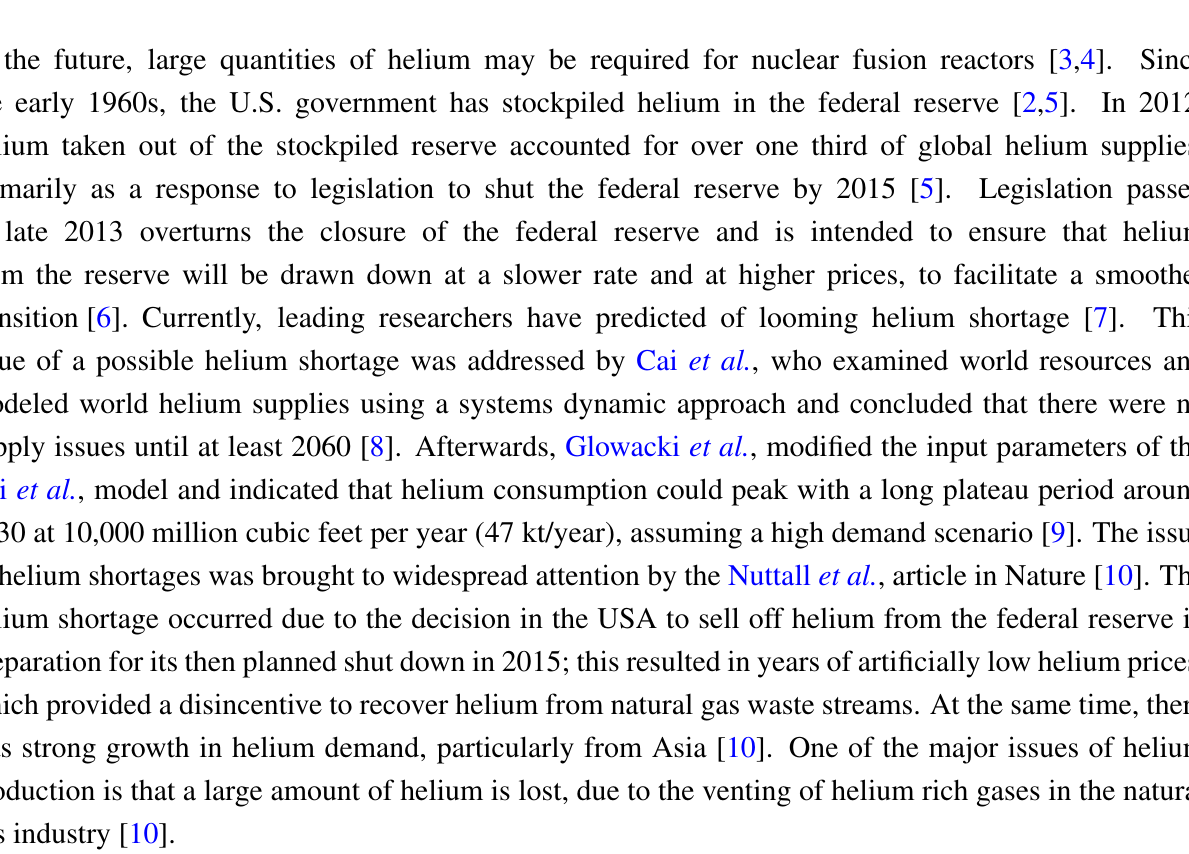
Figure 1. Helium consumption in the USA